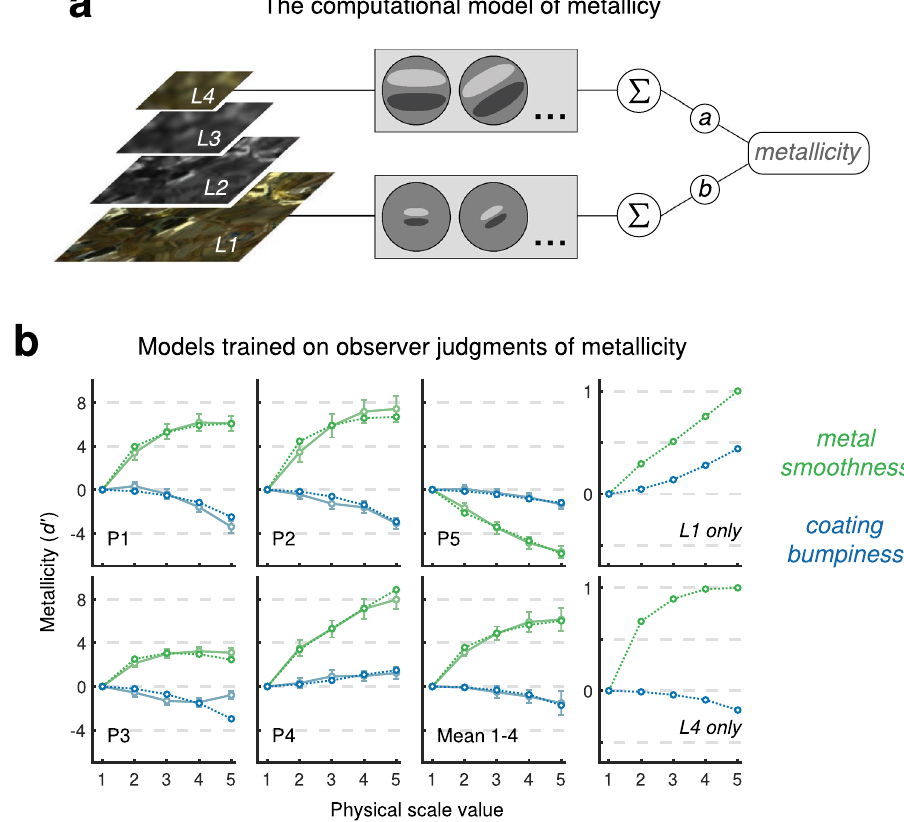
Figure 5. Modeling observer judgments of metallicity. ( a ) The computational model of metallicity, taking a weighted comparison of the outputs of Level 1 and Level 4 of the steerable pyramid decomposition. The pyramid is shown on the left, with higher levels resulting from applying a Gaussian blur to preceding levels and downsampling the spatial resolution by a factor of 2 (not to scale). The same linear oriented filters operate on all levels, such that lower levels generate responses owing to an image’s fine details, and higher levels generate responses owing to coarse features. The model has only two free parameters, a and b , the weightings of responses for Level 4 (coarse features) and Level 1 (fine details). ( b ) This model accounts for the observer judgments of metallicity. Conjoint measurement contributions are shown for metal smoothness (green) and coating bumpiness (blue). Observer estimates obtained via MLCM are shown in faded colors as in Fig. 1, with computational model fits shown in dotted lines. Also shown are the conjoint measurement contributions for computational models using only a single level of the pyramid. Level 1, corresponding to fine image features, at the top right, and Level 4, corresponding to coarse image features, at the bottom right. Error bars for pooled participant data show ± s.e.m. ( N = 4 ) and for individual observers show 95% confidence intervals obtained via bootstrap.